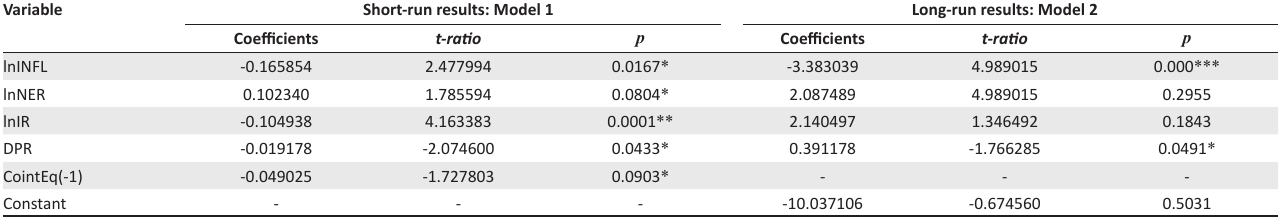
TABLE 4: Short and long run results with structural break. Variable Short-run results: Model 1